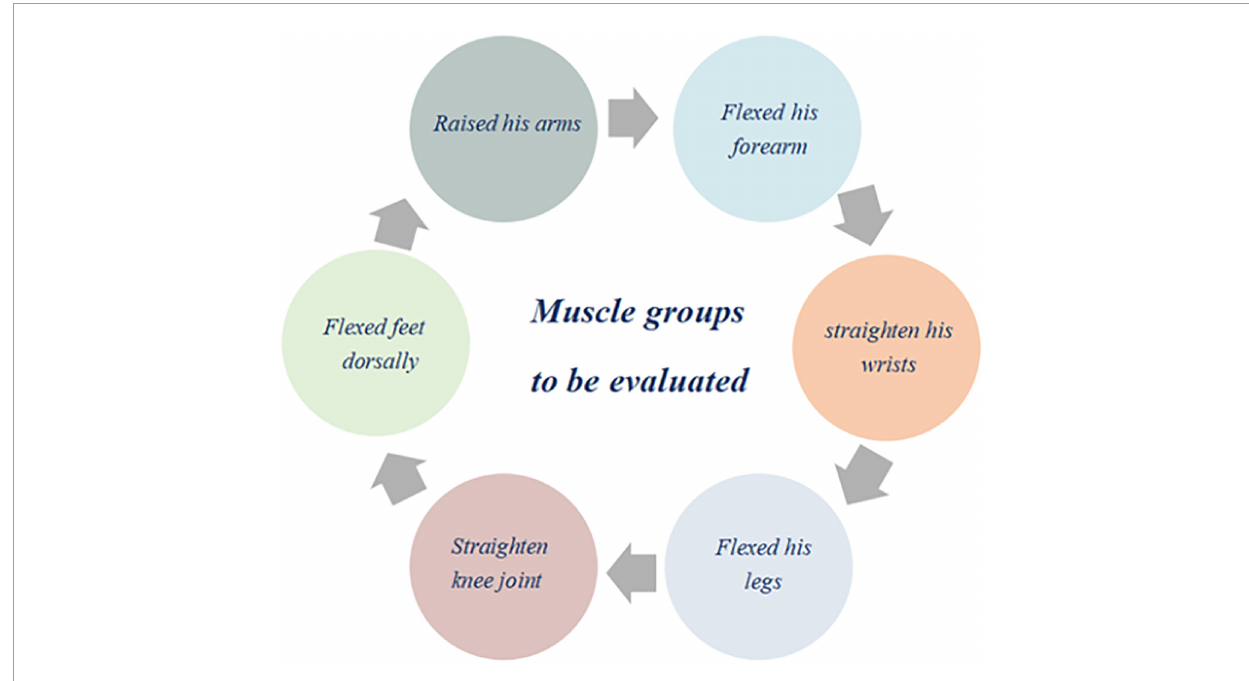
FIGURE1 Muscle group sites used for bedside muscle strength